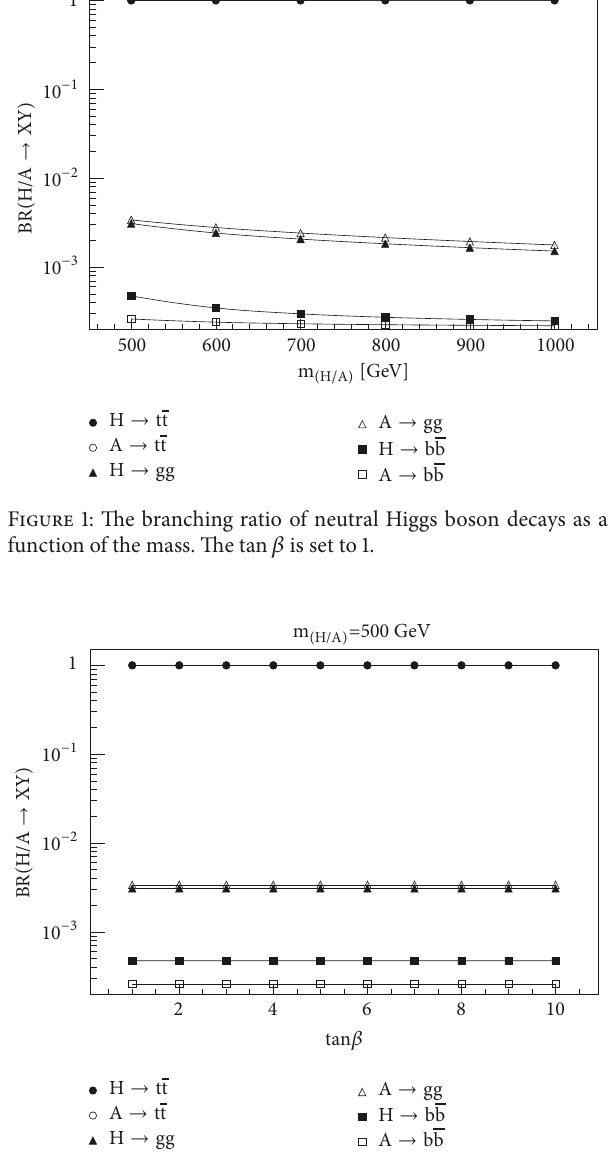
Figure 2: The branching ratio of neutral Higgs boson decays as a function of tan 𝛽 . The Higgs boson mass is set to 500